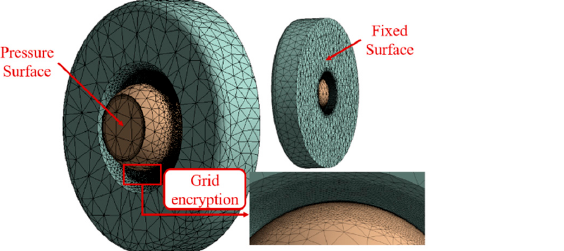
Figure 8. Meshing and simulation boundary conditions.